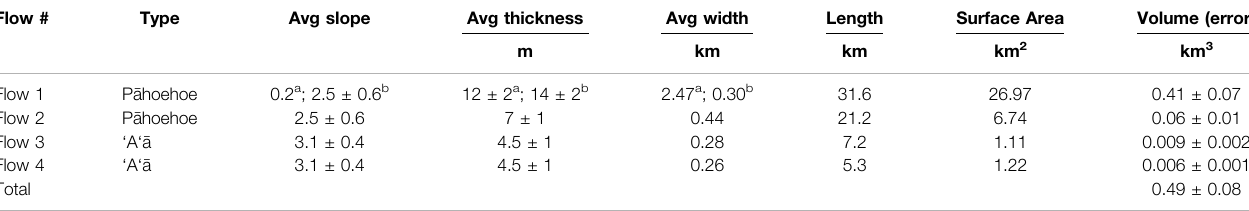
TABLE 1 | Type and geometrical characteristics of the Tseax lava fl ows (from Le Moigne et al., 2020). Flow